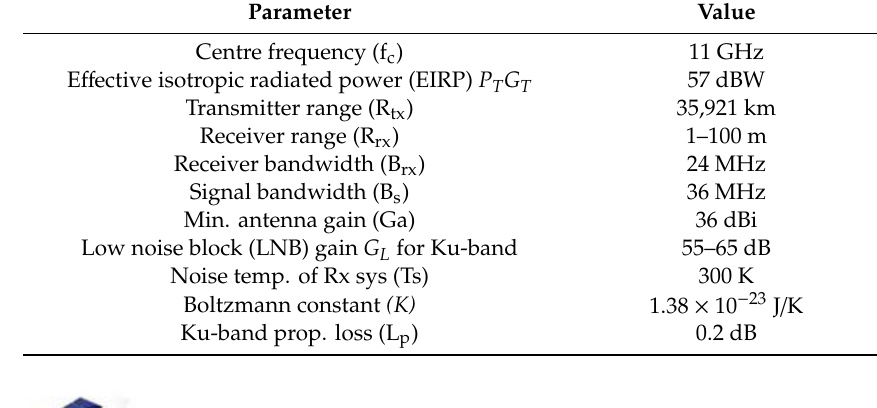
Table 3. The DVB-S Measat3 parameters.